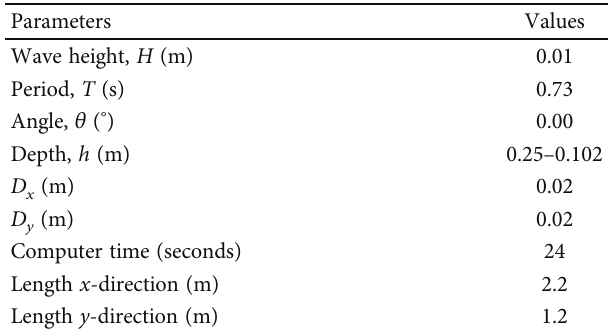
Table 1: Parameters for the simulation of the incident wave in the study